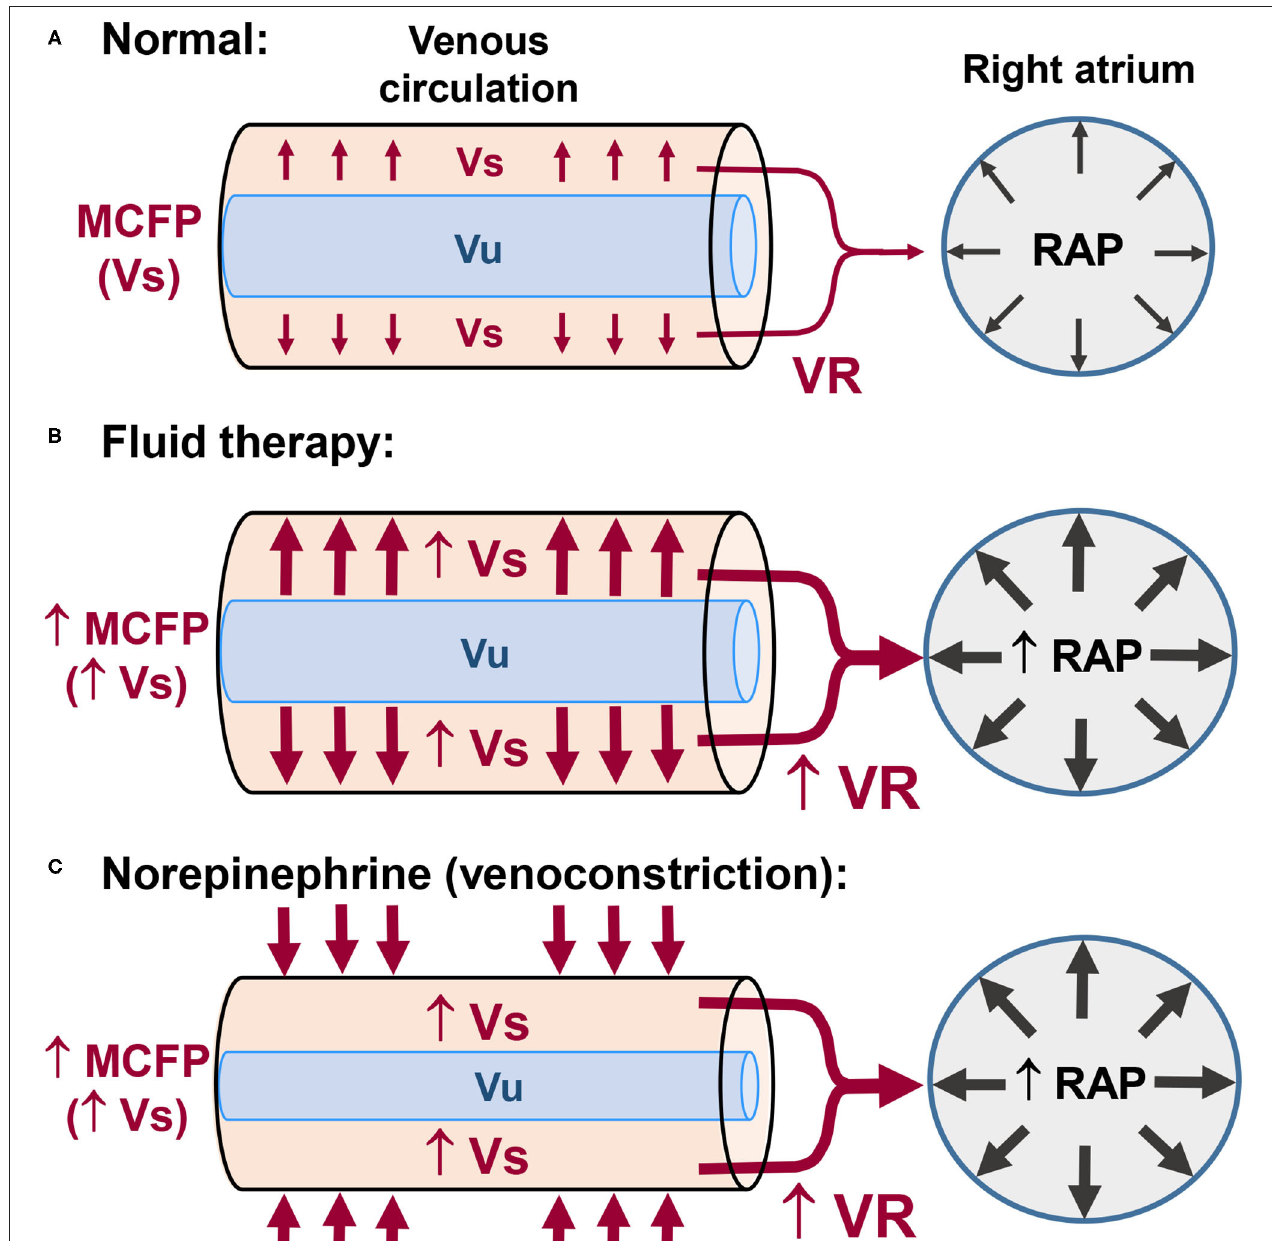
FIGURE 1 | Control of venous return (VR) in normal subjects and the effects of fluid therapy and of vasopressors on VR. (A) The unstressed blood volume (Vu) maintains the vessels minimally opened. The stressed blood volume (Vs) exerts pressure on the vessel walls and is responsible for the mean circulatory filling pressure (MCFP). The pressure gradient between the upstream veins (MCFP) and right atrial pressure (RAP) is the major driving force responsible for VR of blood from the systemic circulation to the right side of the heart. (B) Intravenous fluid administration may increase VR and RAP (preload) via increases in Vs and MCFP. (C) Venoconstriction induced by low doses of vasopressors (e.g., norepinephrine) may also increase VR and RAP via increases in Vs and